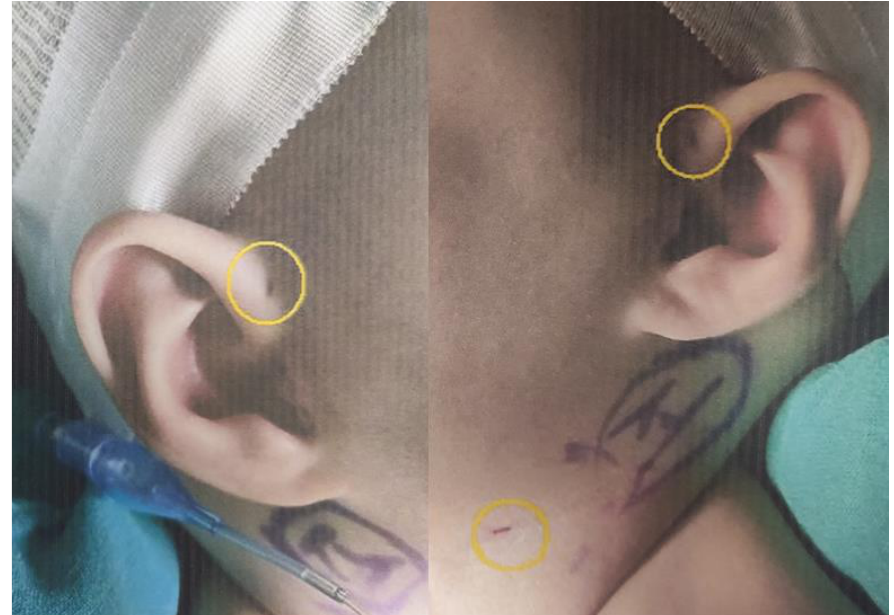
Figure 3. Bilateral preauricular pits and left branchial cyst and fistula opening.